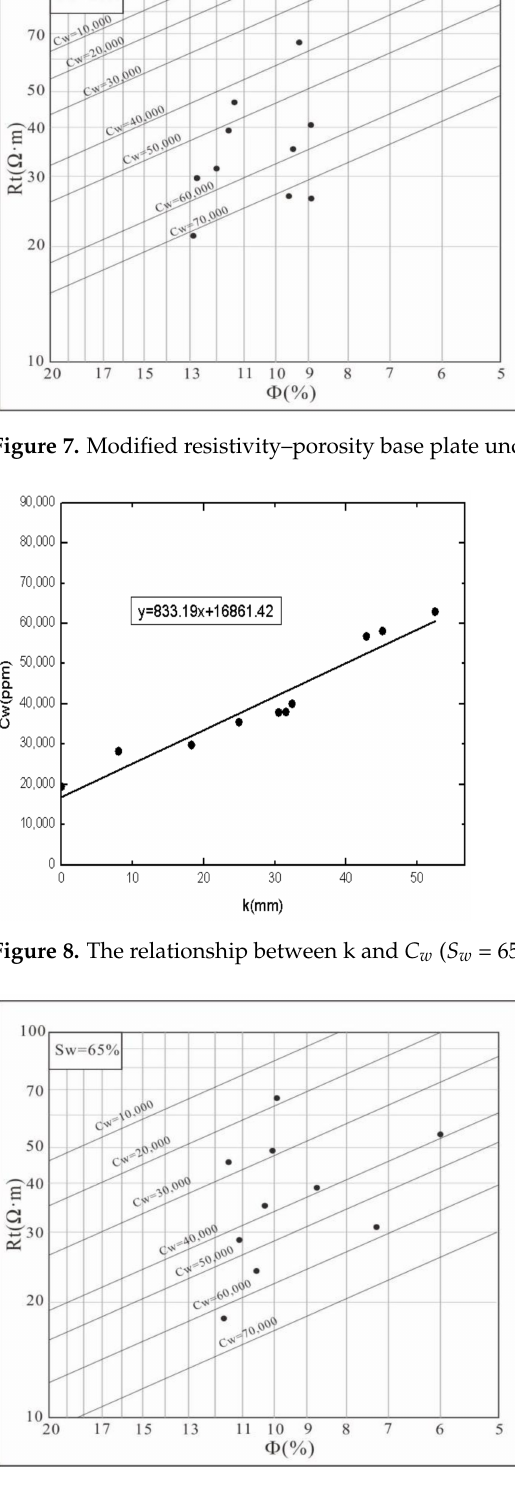
Figure 9. Modified resistivity–porosity base plate under variable salinity conditions ( S w = 65%). When S w 2 is 80%, we find the Z226 well has the smallest C w of 28,367 ppm. Then, the k value corresponding to the formation water salinity is calculated. Figure 10 shows the rela- tionship between k and C w with S w 2 of 80%, and the fitting equation is C w = 778.08 k + 28,342.19. We obtain the values of k with C w of 10,000 ppm, 20,000 ppm, 30,000 ppm, 40,000